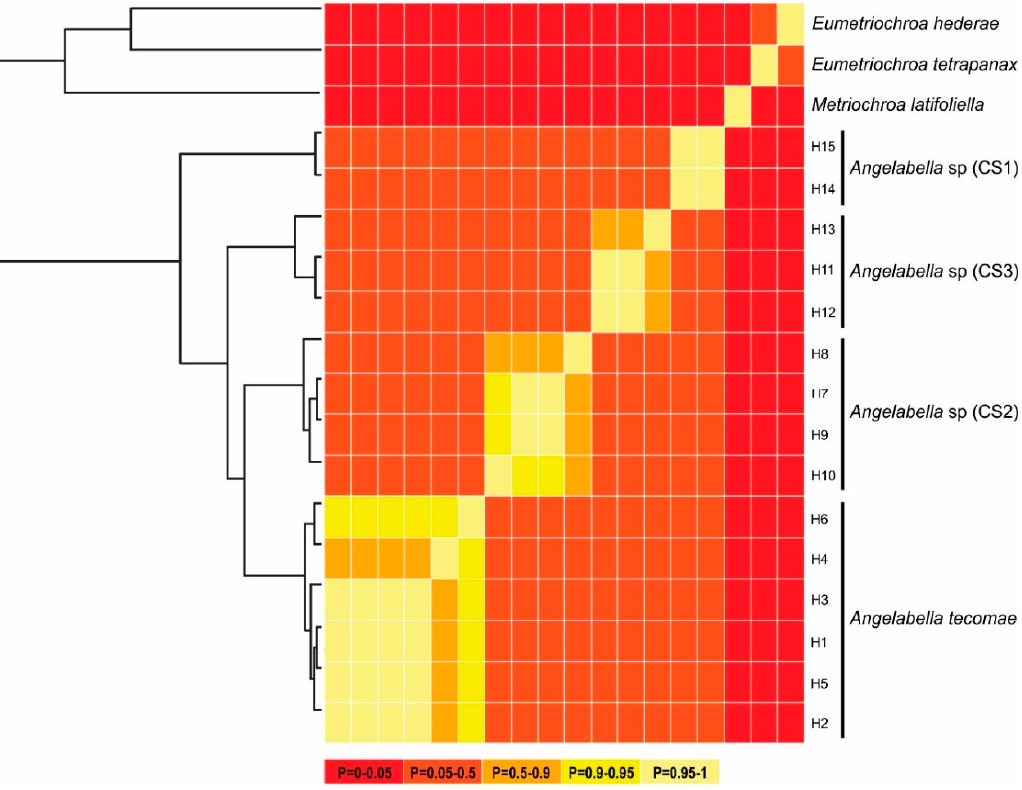
Figure 4. Summary of Bayesian General Mixed Yule Coalescent (bGMYC) results. Maximum clade credibility tree from BEAST (left) and sequence-by-sequence matrix (right). Colors of cells represent the posterior probability that the sequences are conspecific.